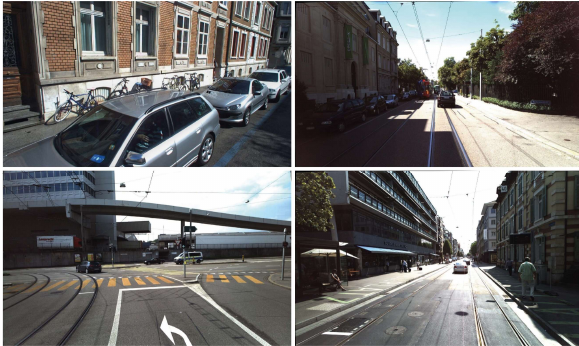
Figure 3. Four representative query images of our Basel Bench50 dataset